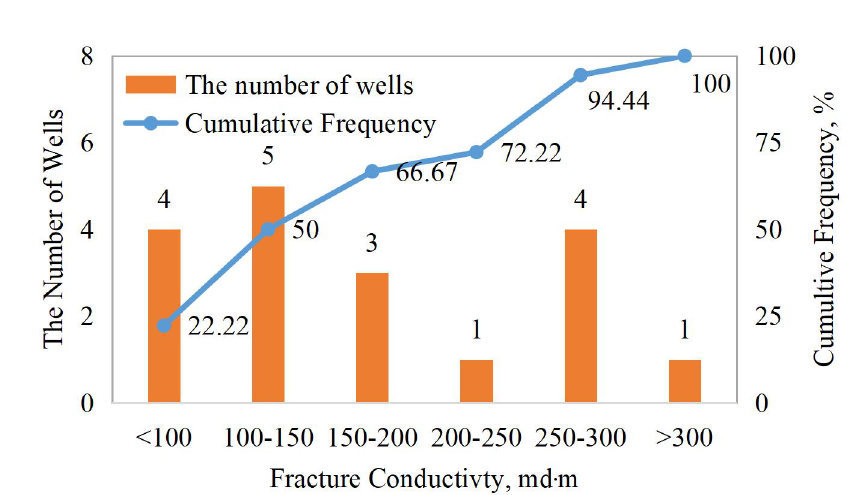
Figure 16—Cumulative frequency distribution of horizontal well fracture conductivity